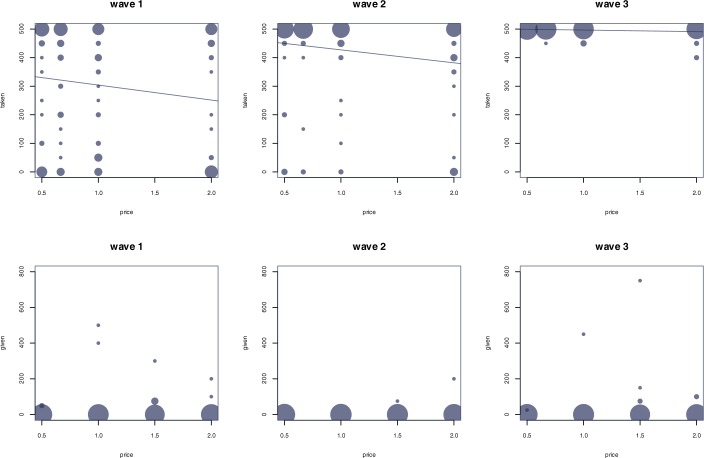
Amounts taken from players B in the take games (the upper 3 graphs) and amounts given to players B in the give games (the lower 3 graphs).